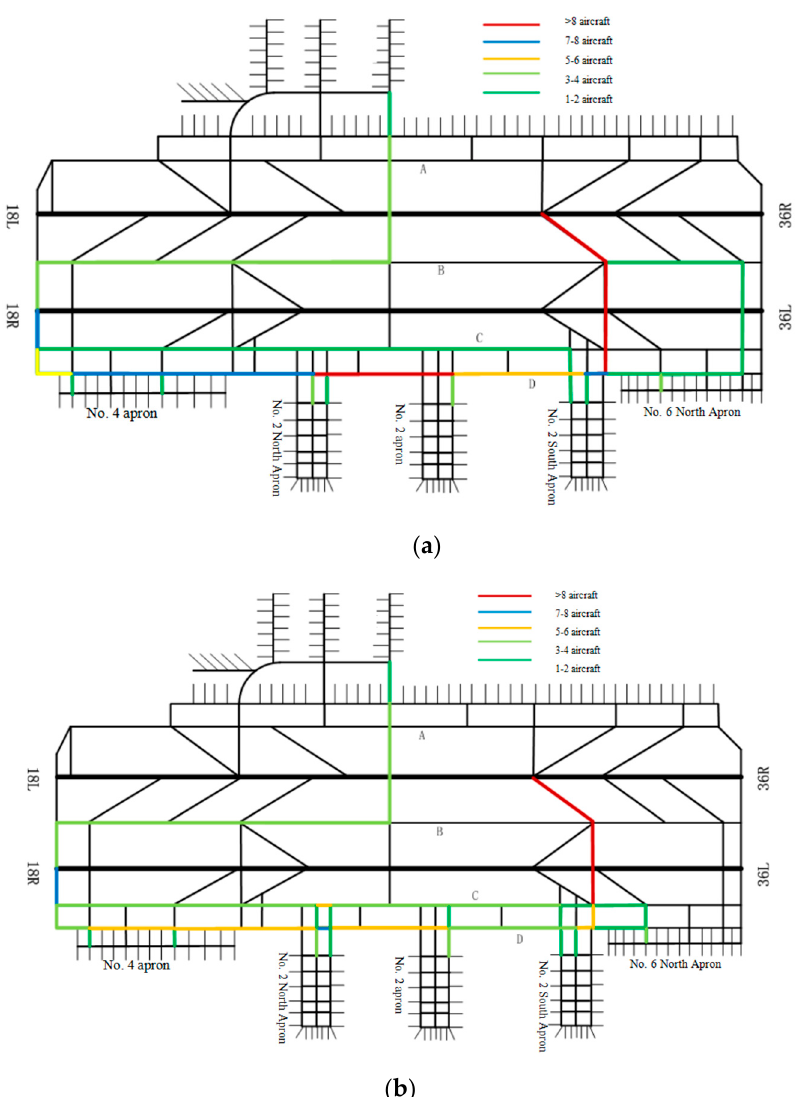
Figure 8. Number of aircraft taxiing on various taxi paths before and after path optimization. ( a ) Before optimization; and ( b ) after optimization.